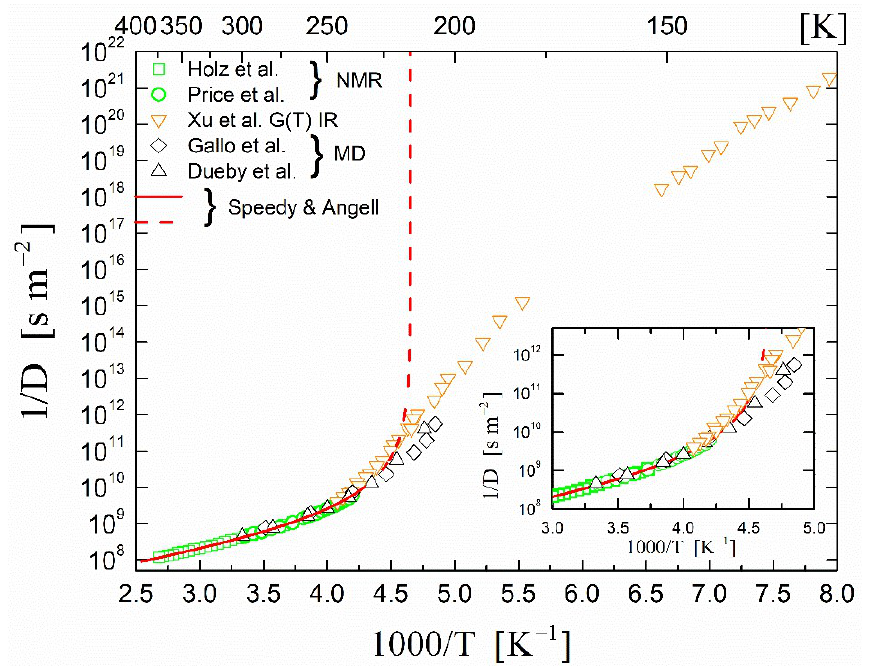
Figure 1. Temperature dependence of the inverse self-diffusion coefficient 1/ D in supercooled bulk H 2 O. Squares ( (cid:3) ) (Holz et al. [44]) and circles ( ) (Price et al. [45]) represent the self-diffusion coefficient ( D ) obtained from pulsed field gradient NMR experiments. The solid line is the singular Speedy and Angell [1] power law fit to the experimental data. The dashed line is the continuation of the fit below 238 K to show the singularity of the power law. Inverted triangles ( (cid:53) ) are self-diffusion coefficients derived from growth rates of crystalline ice experiments (Xu et al. [46]). Diamonds ( ♦ ) (Gallo et al. [47]) and upright triangles ( (cid:52) ) (Dueby et al. [48]) are self-diffusion coefficients derived from molecular dynamics simulations. The inset is an expanded temperature region around 238 K.